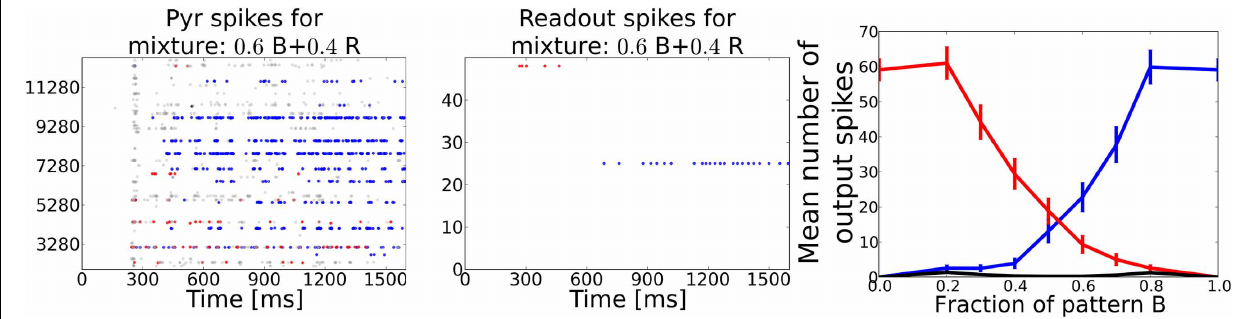
often occurring misclassifications during the recognition of odor mixtures. Middle: Raster plot corresponding to the pattern from left panel showing spikes emitted by readout cells that were active during the two respective training patterns. The stronger pattern is being recognized starting from ∼ 700ms, i.e. approximately after 500ms or two sniff cycles (simulated sniffing frequency is around 4Hz. Right: Average curves showing the mean number of spikes emitted by the readout cells trained to recognize one of the two test patterns. Black curve shows the mean response from readout cells that code for none of the two test patterns. The blue and the red curve indicate a smooth transition from one pattern to the other depending on the relative strength in the